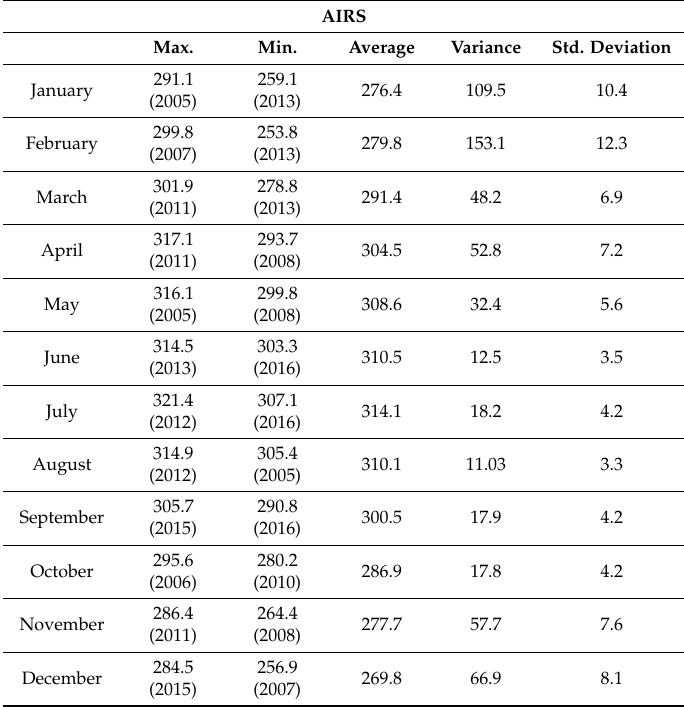
Table 3. Interannual monthly regional average statistics TOC for 12 years from AIRS. Numbers in parentheses represent the corresponding year.